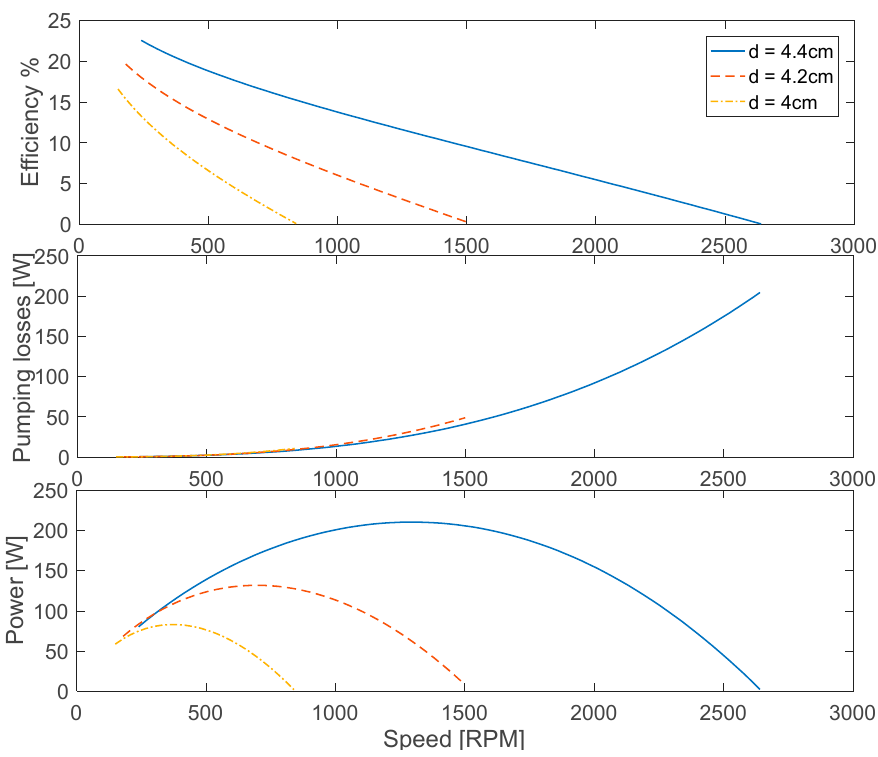
Figure 7. Influence of increasing the isothermal fins diameter on the Franchot engine performance. Inventions 2017 , 2 , 35